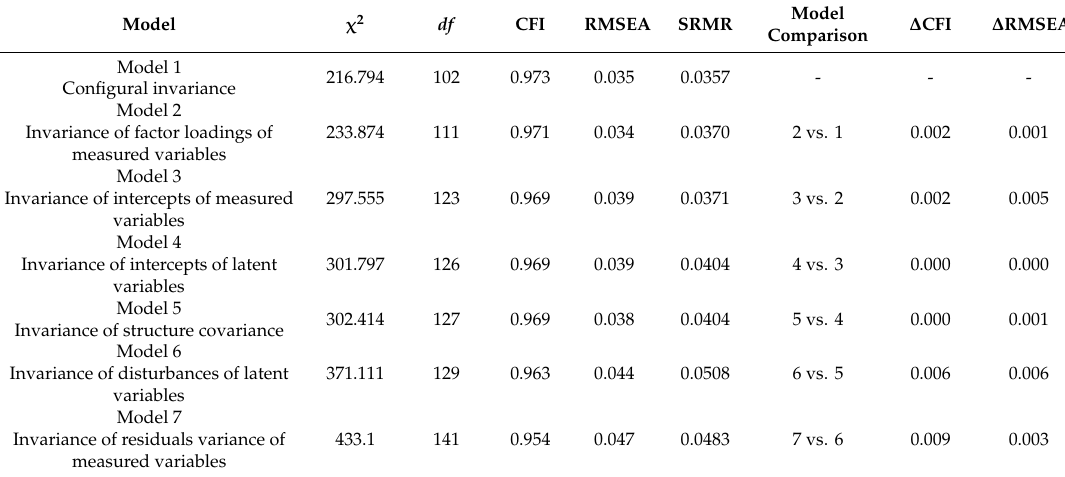
Table 2. Fit indices for multi-group analysis across